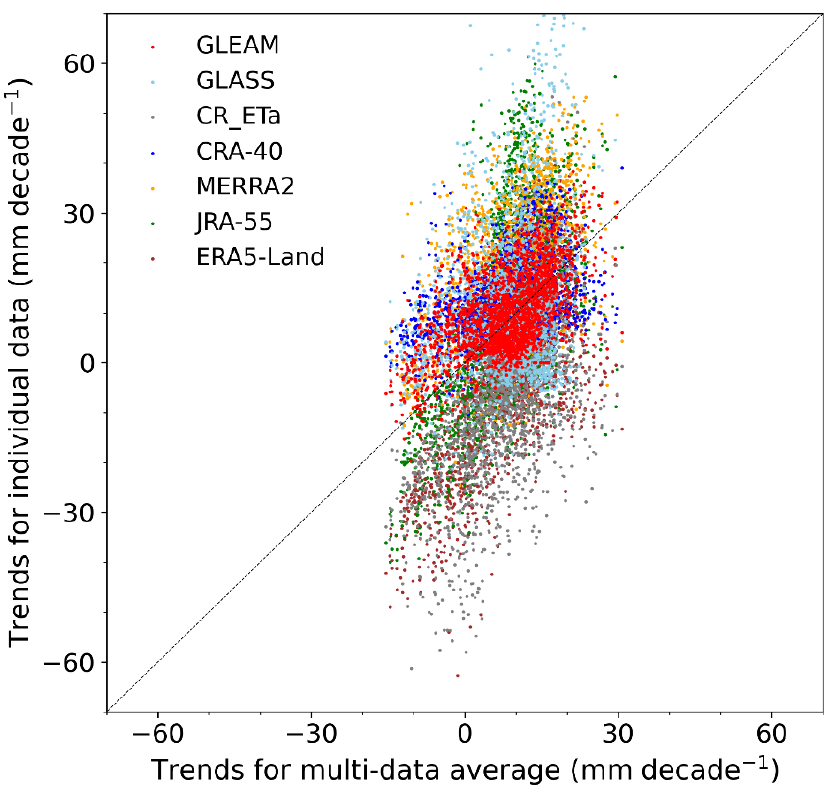
Figure 4. Trends in ETa obtained from GLEAM, GLASS, CR_ETa, CRA-40, MERRA2, JRA-55, and ERA5-Land as a function of trends in ETa for the ensemble average of seven datasets in northern China from 1982 to 2017 (unit: mm·decade −1 ).